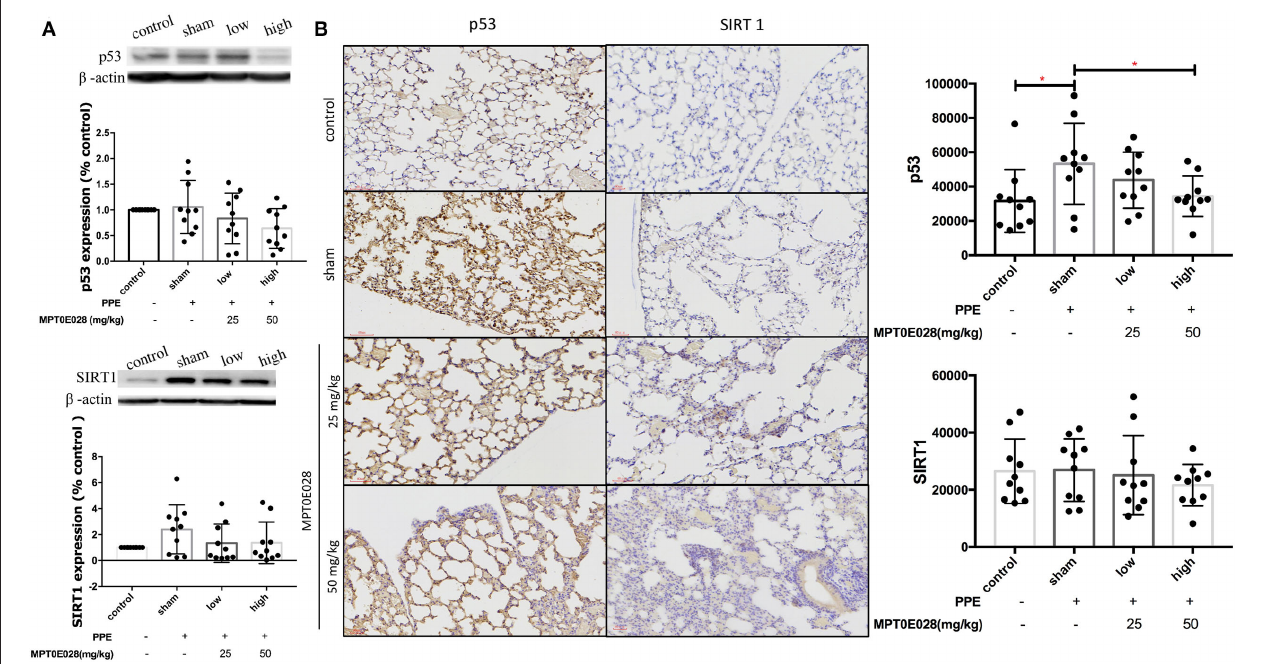
FIGURE 6 | Expressions of sirtuin 1 (SIRT1) and p53 in the lungs and alveolar regions by the MPT0E028 in mice with porcine pancreatic elastase (PPE)-induced emphysema. (A) Expressions of SIRT1 and p53 in whole lung lysates by the MPT0E028 at 0, 25, and 50 mg/kg body weight (BW) ( n = 10). (B) Expressions of SIRT1 and p53 in alveolar regions by IHC by the MPT0E028 at 0, 25, and 50 mg/kg BW ( n = 10) (magnification X20). * p <